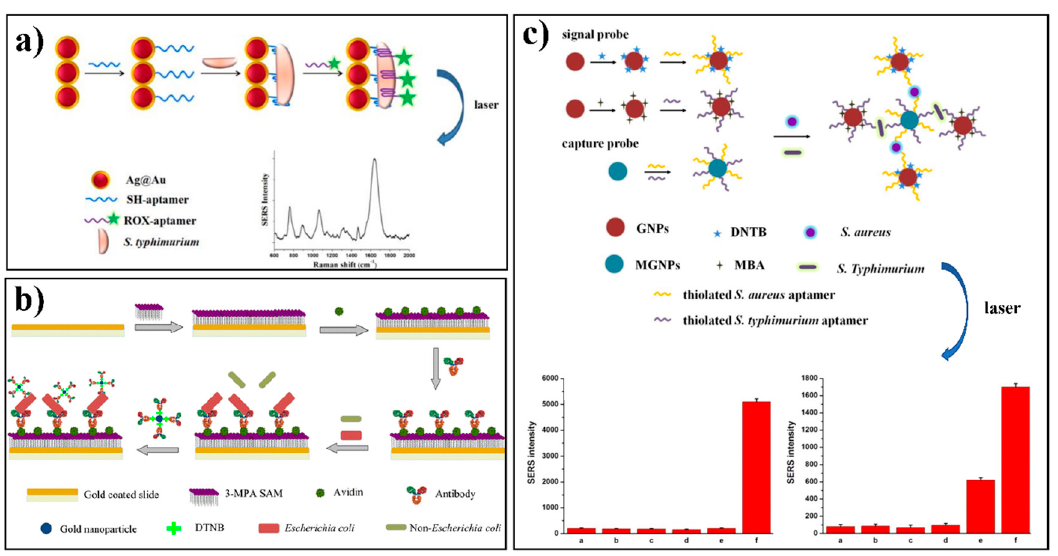
Figure 4. ( a ) Schematic illustration of aptamer-based SERS approach for the detection of Salmonella Typhimurium. Ag/Au core/shell nanoparticle was conjugated with a specific aptamer. The Raman reporter, X-rhodamine (ROX), was labeled on the same aptamer sequence. Nanoparticle-aptamer- target-aptamer-Raman reporter complexes enabled SERS detection. ( b ) Schematic illustration of the antibody-based sandwich-type SERS immunoassay for Escherichia coli enumeration. SERS tags were constructed by gold nanoparticles first coated with a Raman reporter molecule, 5,5 ′ -dithiobis (2-nitrobenzoic acid) (DTNB), and subsequently with a corresponding antibody. ( c ) Multiplex detection of Salmonella Typhimurium and Staphylococcus aureus using aptamer-SERS immunoassay. Fe 3 O 4 magnetic gold nanoparticles were labeled with unique Raman reporters and aptamers against S. aureus and S . Typhimurium and then employed into a sandwich-like assay. Reproduced with permission